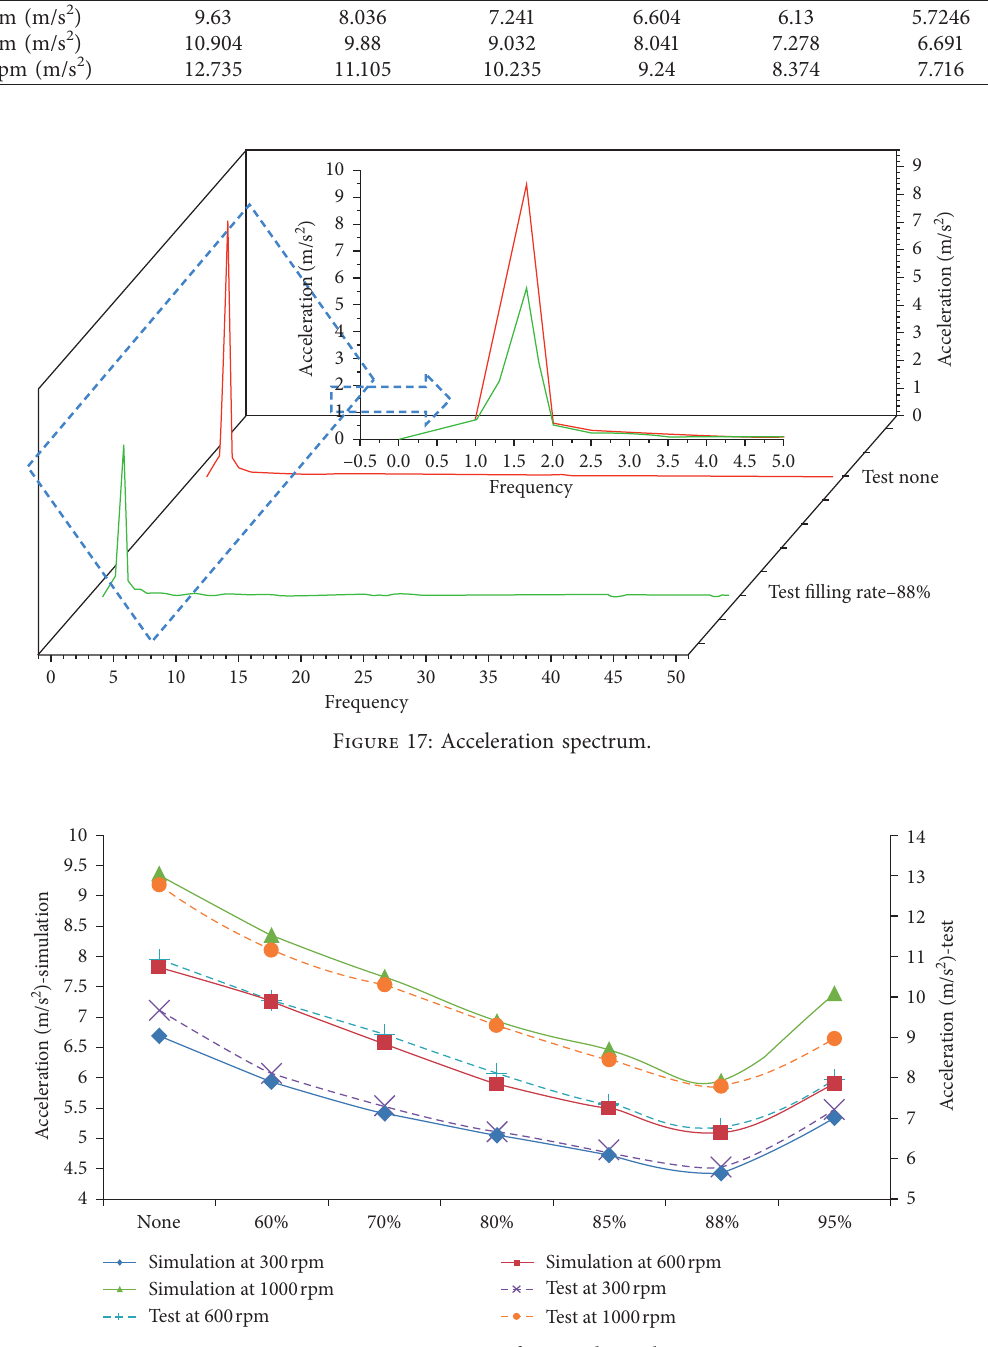
Figure 18: Comparison of test and